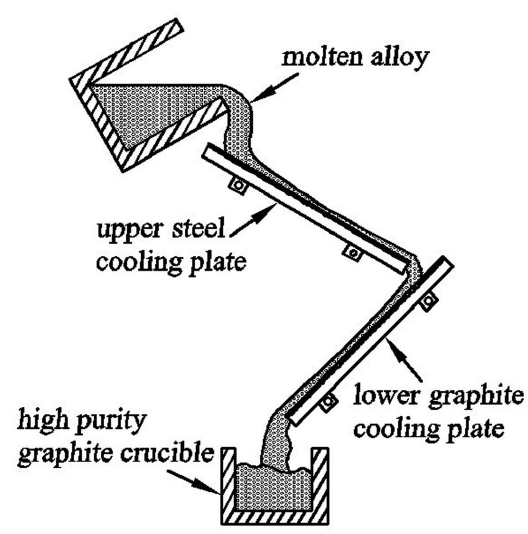
Figure 1. CS casting unit.